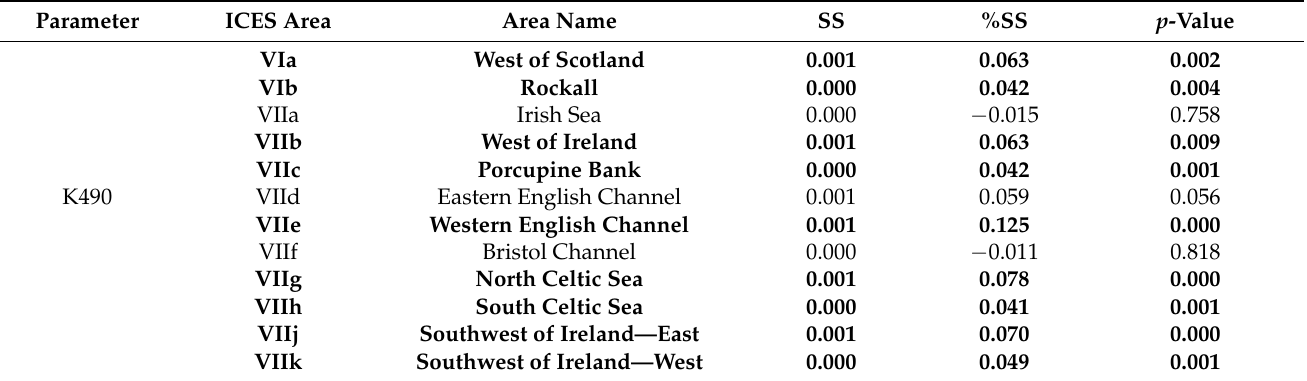
Table 3. K490 trend values resulting for each ICES division. SS-Sen slope (1/m/year), %SS